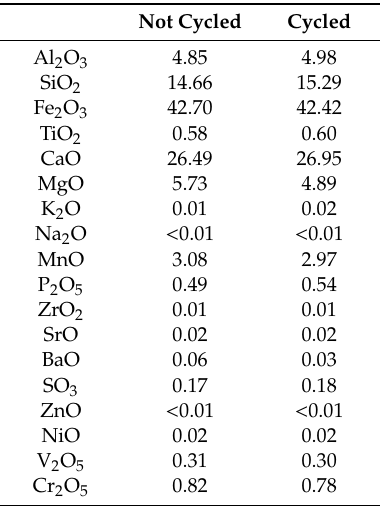
Figure 17. Weight of raw slag ( a ) and powder made of raw slag ( b ) over the duration of thermal cycling. Table 9. Chemical composition of powders made of raw slag: Cycled and not The change in weight is very small in the case of raw slag. In the case of powder, a significant